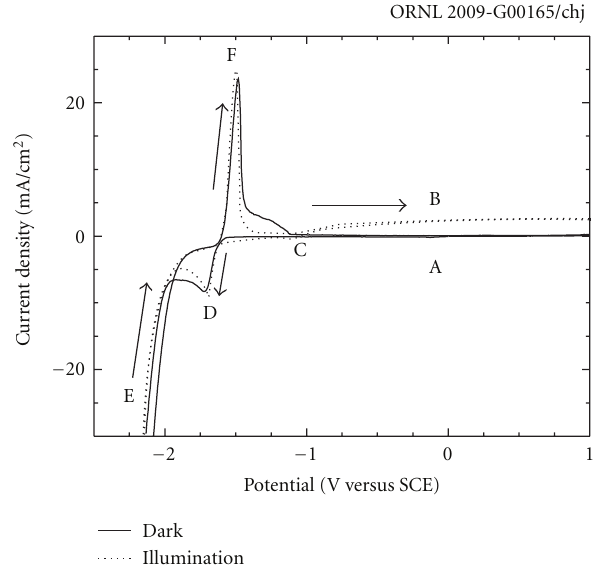
Figure 1: Current density versus applied potential curves for ZnO single-crystal electrode sample no. 4 (see Table 1) in the dark (solid line) and under illumination (dotted line). Regions A and B are reverse biased, showing photocurrent (B) under illumination or no current (A) in the dark. Position C is flat band, D is the cathodic peak, and F is the anodic peak. Bubbles formed at the electrode in region E. The arrows are used to emphasize the direction of the cyclic potential